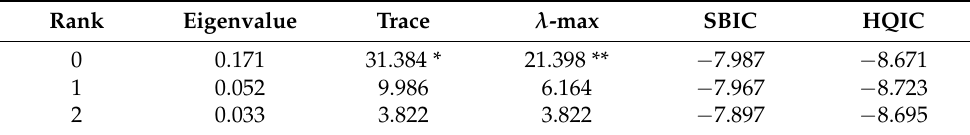
Table 3. Johansen cointegration results.